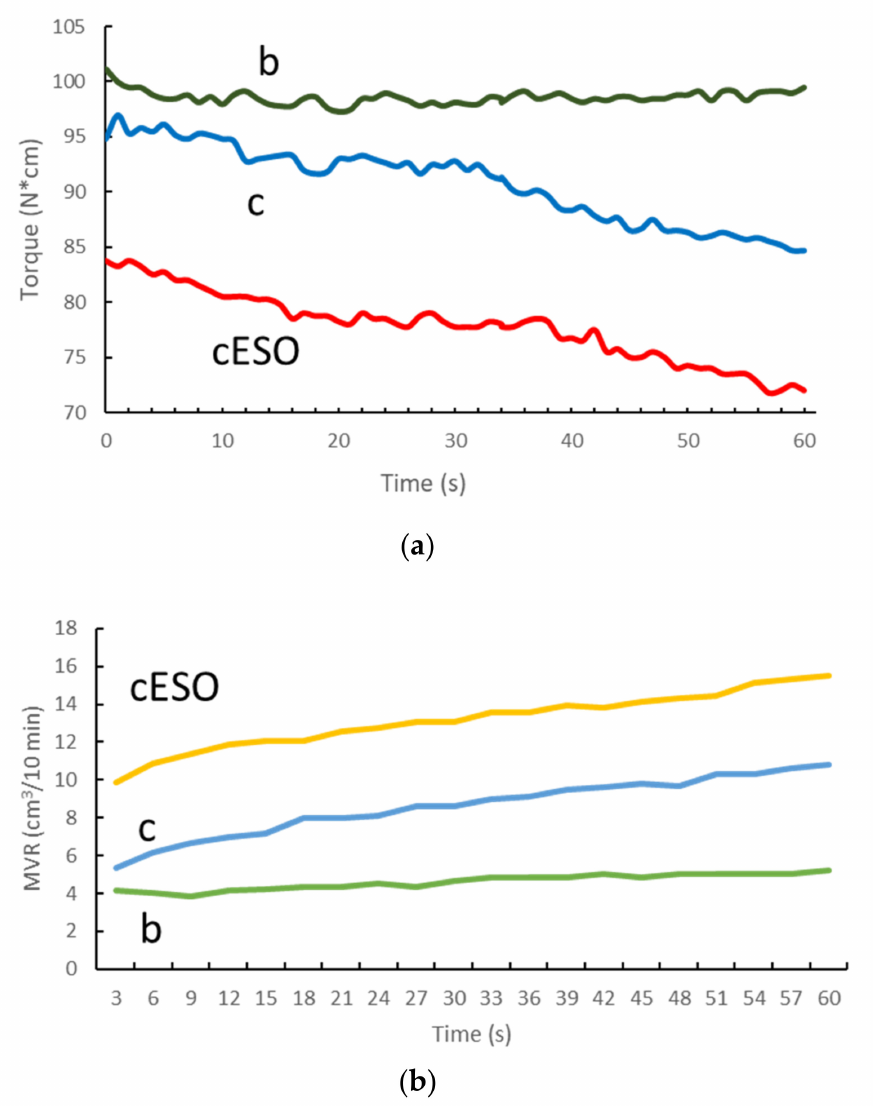
Figure 4. ( a ) Torque during extrusion and ( b ) melt volume rate trend as a function of testing time for the PLA/PBSA blend (b trend), the composite with 20% bran (c trend) and the latter with ESO (cESO